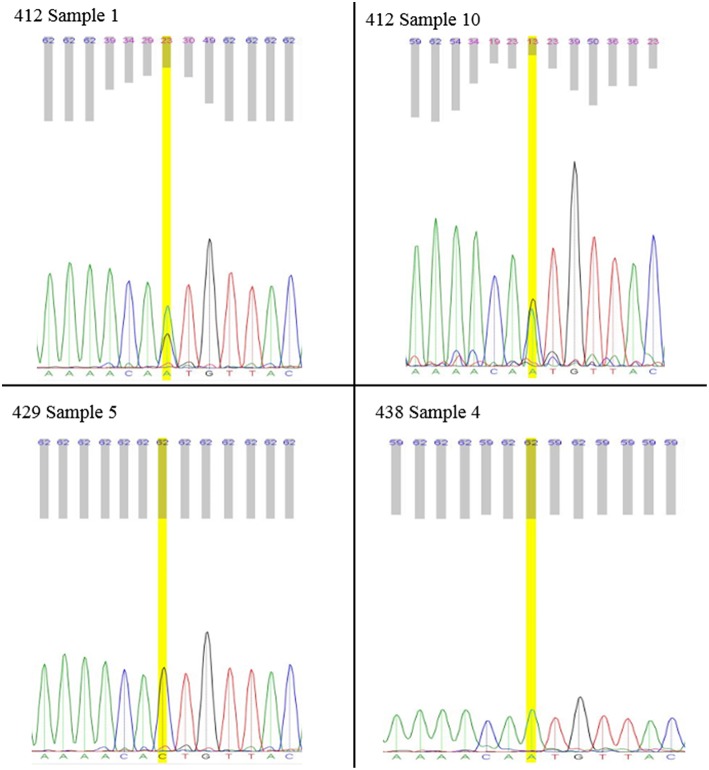
Individual L1's Sanger Electropherogram. Sanger results for mitochondrial position 8439 heteroplasmy of individual gas-1 worms. Electropherograms for MA412 samples display presence of both “A” and “C” alleles. MA429 is, fixed for the wild-type “C” allele. MA438 is fixed for the alternate “A” allele. Lower phred scores, displayed above electropherograms, indicate uncertainty in base calling associated with heteroplasmic sites.